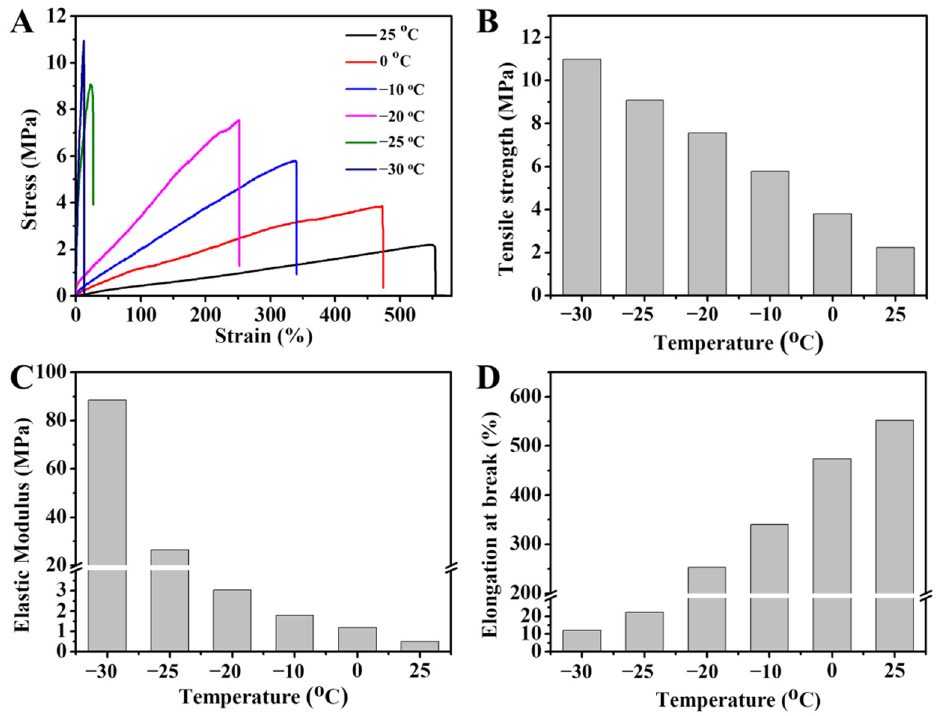
Figure 7. ( A ) The stress–strain curves and the detailed mechanical property parameters of the DN hydrogel at different temperatures: ( B ) tensile strength, ( C ) elastic modulus, and ( D ) fracture strain.